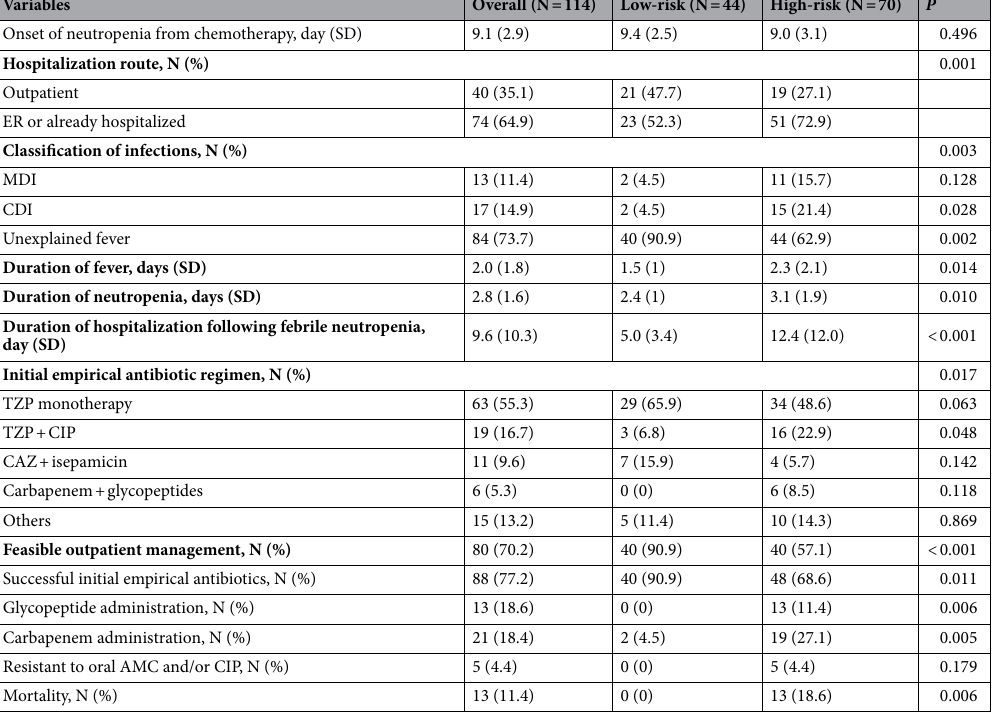
Table 2. Comparisons of clinical features and outcomes between low-risk and high-risk groups. SD standard deviation, ER emergency room, MDI microbiologically defined infection, CDI clinically defined infection, TZP piperacillin/tazobactam, CIP ciprofloxacin, CAZ ceftazidime, AMC